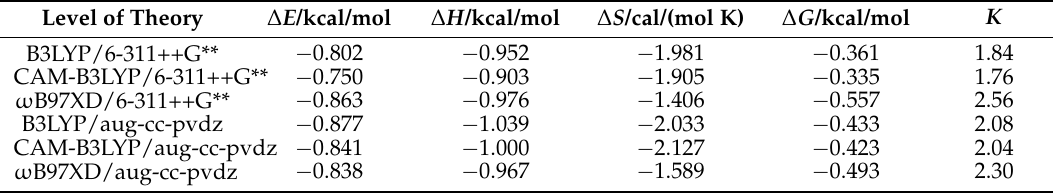
Table 4. B3LYP, CAM-B3LYP and ω B97XD functionals with 6-311++G** and aug-cc-pvdz basis sets zero-point reaction energies, enthalpies, entropies, free energies, and equilibrium constants for the equilibrium I ↔ II at 298.15 K.